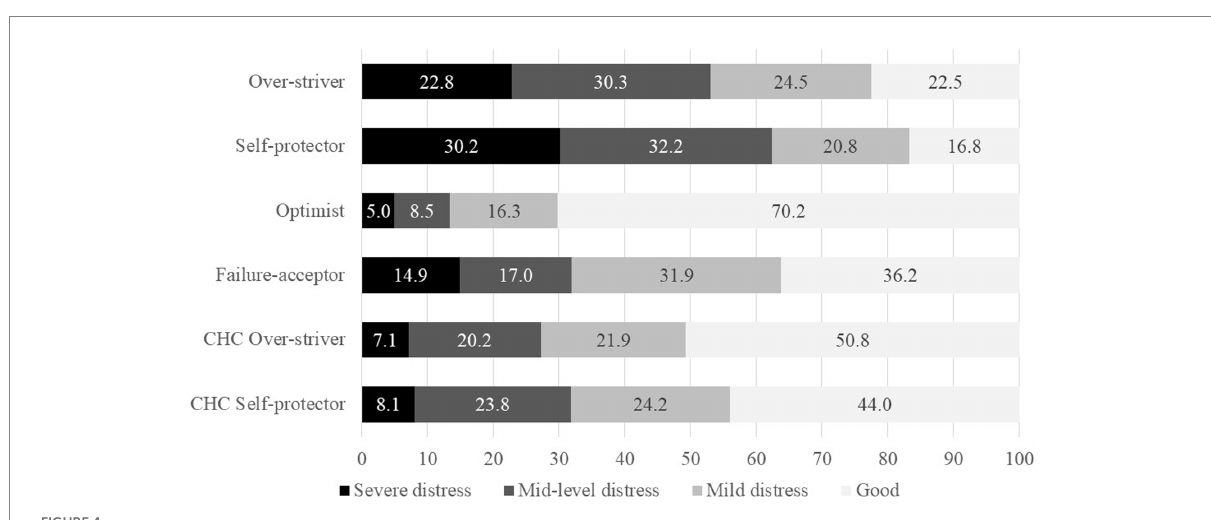
FIGURE 4 Levels of emotional distress across categories (by